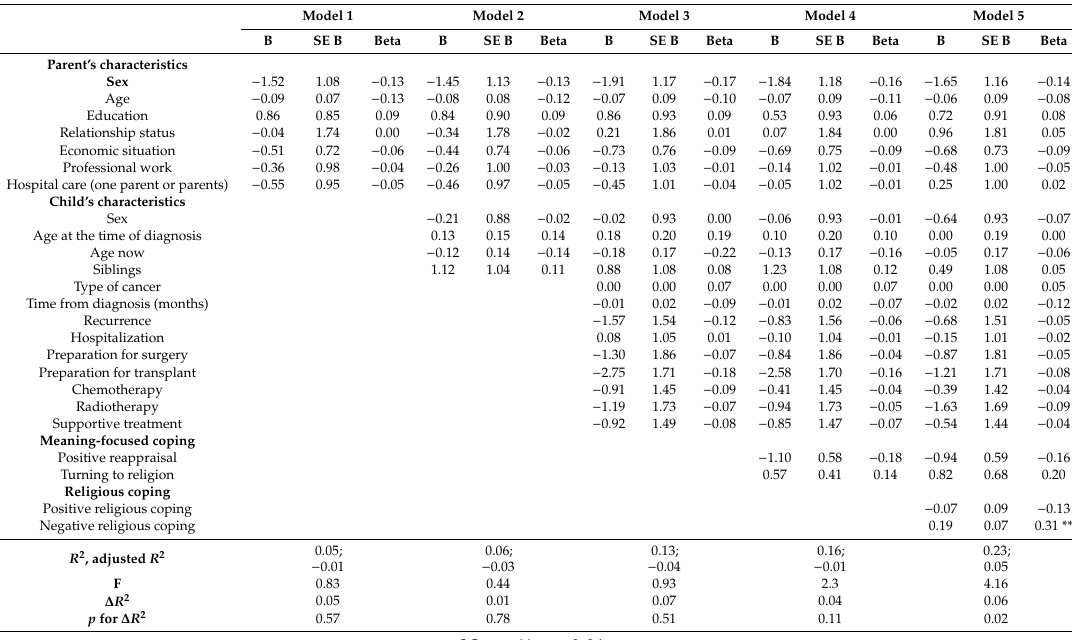
Table 3. Results of hierarchical regression analysis for negative